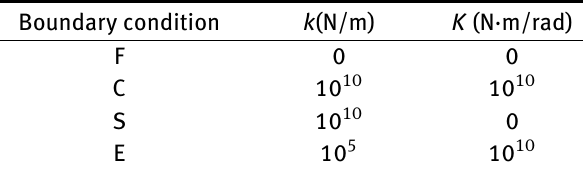
spring is greater than 10 10 N·m/rad, the natural frequency of plate is almost invariant. Which means the boundary condition has changed from simply supported to clamped.